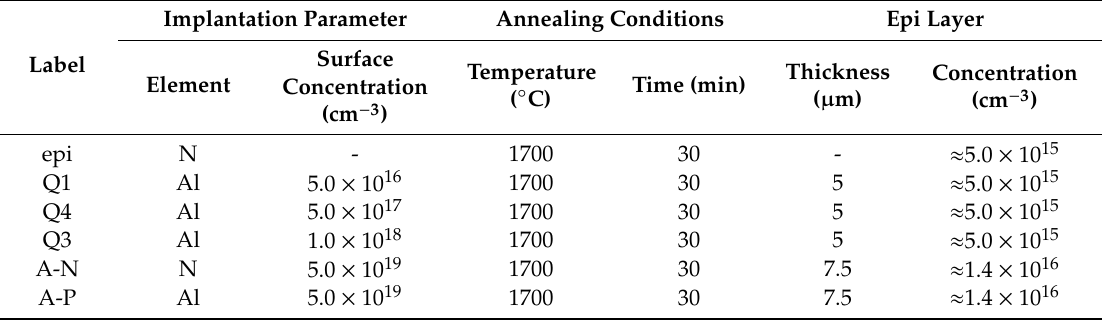
Table 1. The 4H-SiC samples information.